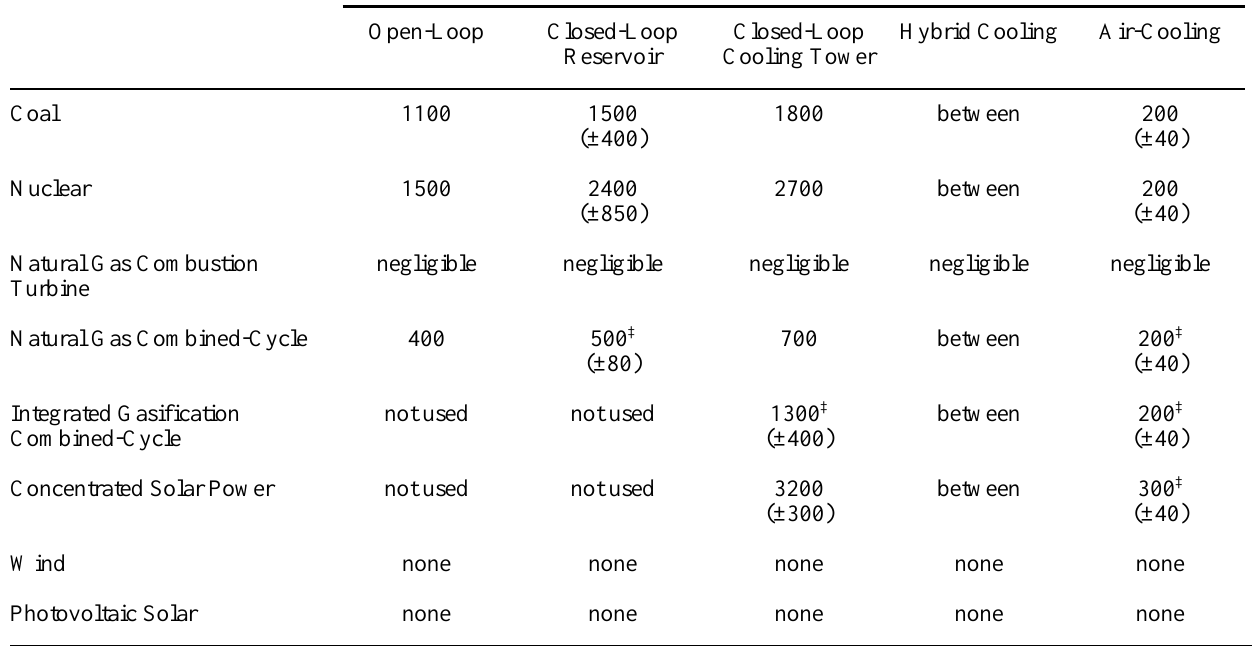
Table 2 . Water consumption reported volumes for different fuels and cooling technologies (Gleick 1994, Goldstein and Smith 2002a, Woods et al. 2007, National Renewable Energy Laboratory 2008). Air-cooling requires negligible water and is compatible with all of the technologies